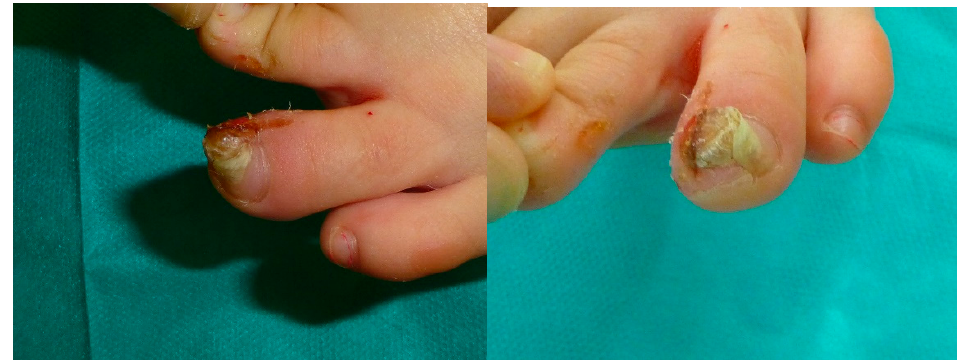
Figure 2. Surgical procedure and clinical outcome of a case with subungual osteochondroma. Preoperative appearance of the lesion. Appearance immediately after the distal wing block anesthesia. Note the subungual mass.